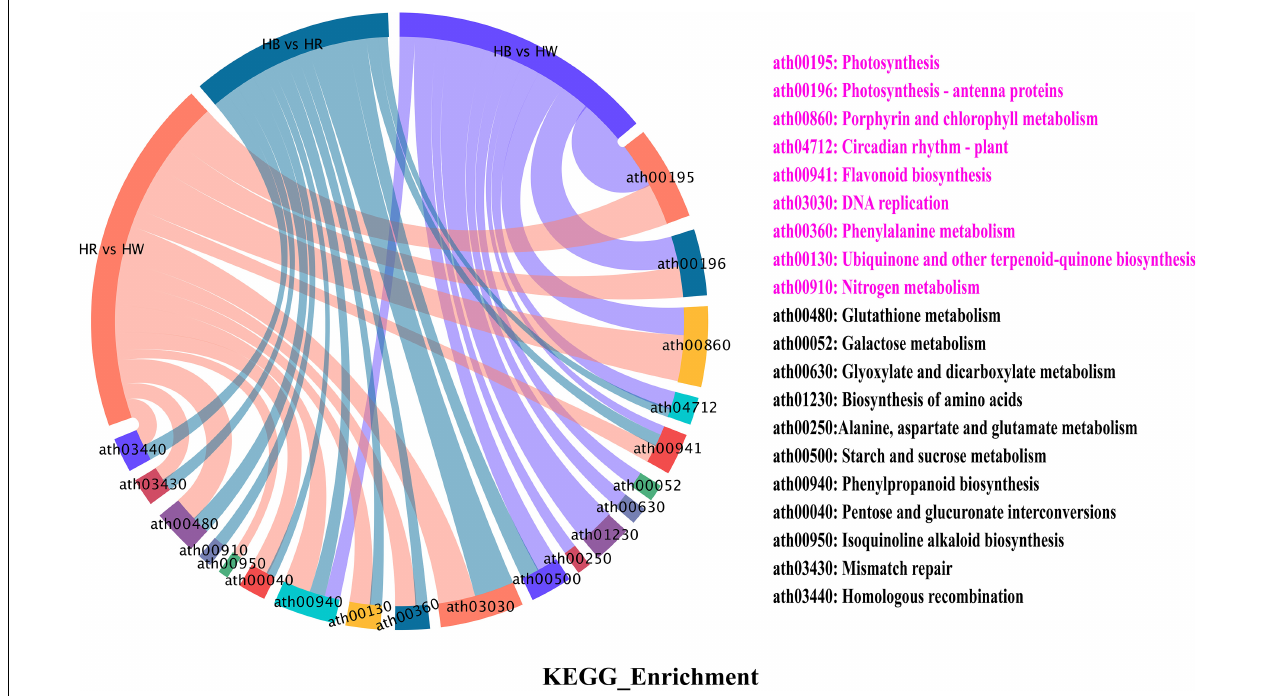
FIGURE 4 | KEGG enrichment of all differential genes (DEGs). The left side of the figure is the schematic diagram of the enriched categories of different genes in different comparison groups. On the right side of the figure are the notes of the enriched categories, and the pink text indicates the significantly enriched categories. HW, HR, and HB indicates samples treated by white light, red light, and blue light,